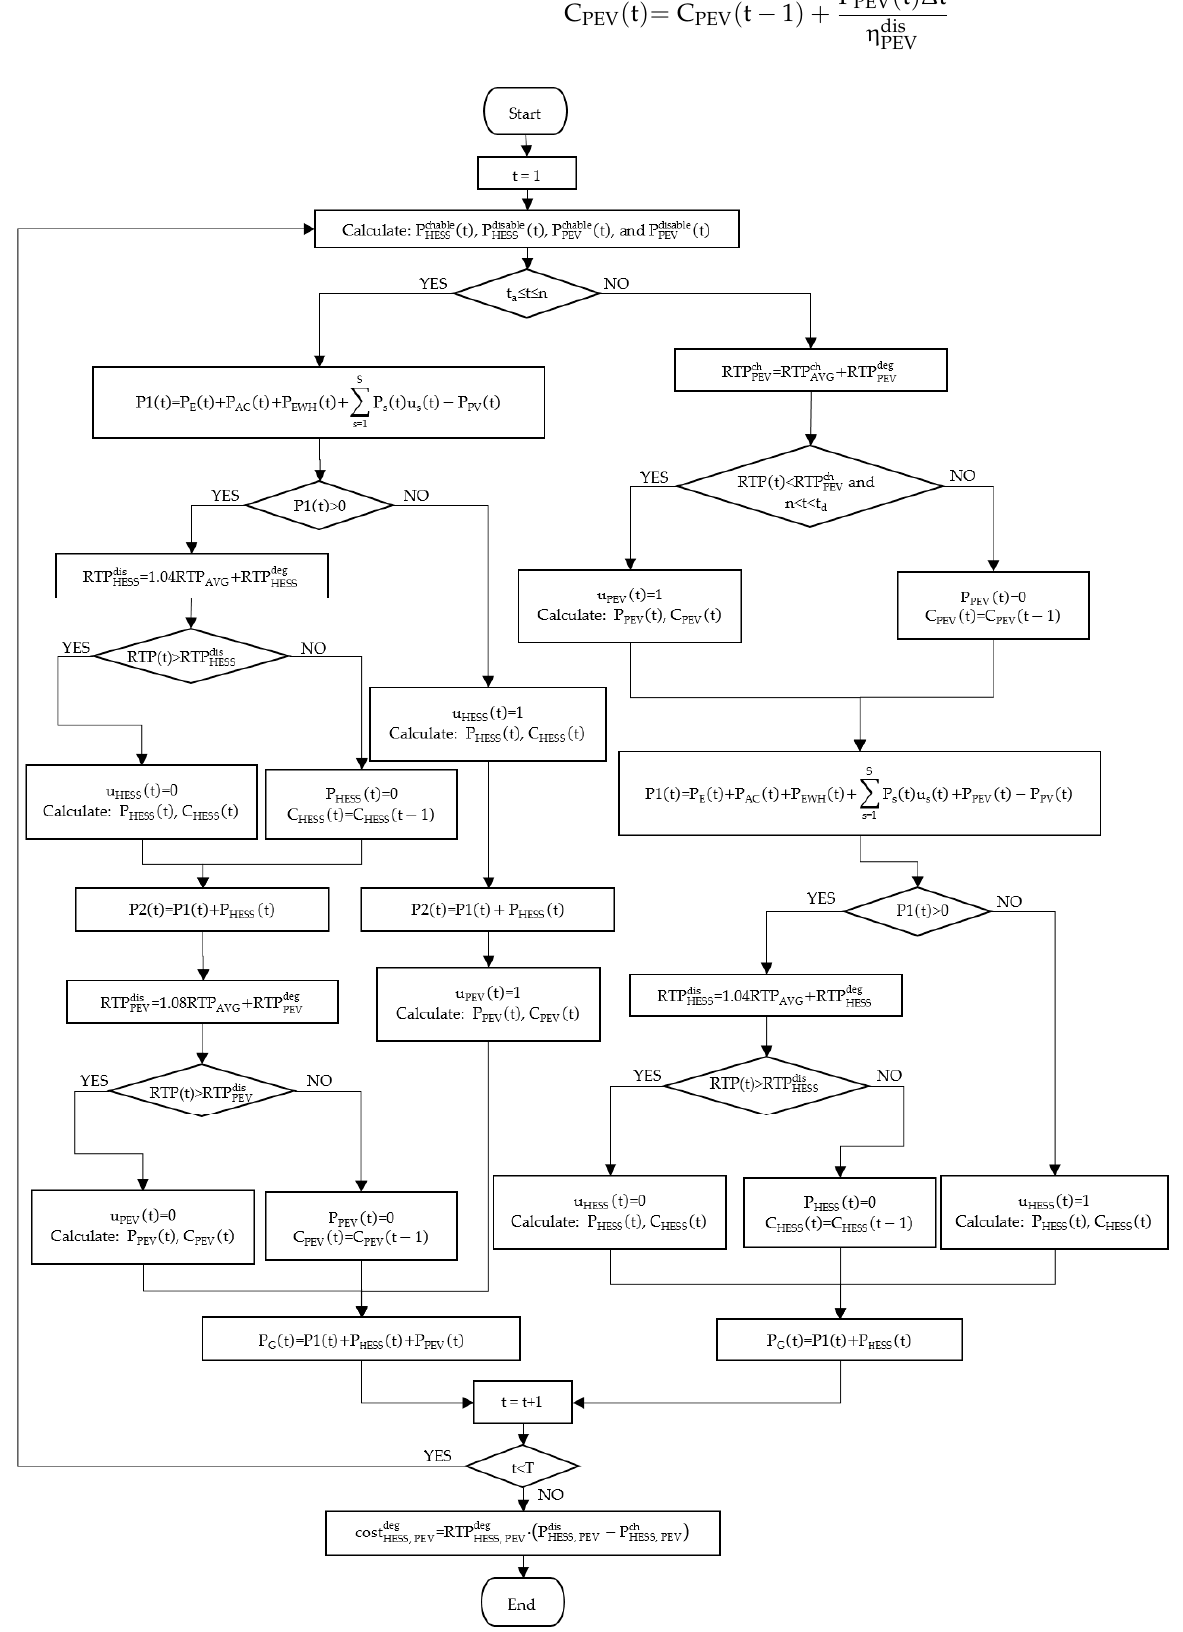
Figure 3. Flow chart of the charging and discharging strategy for the batteries of HESS and PEV.